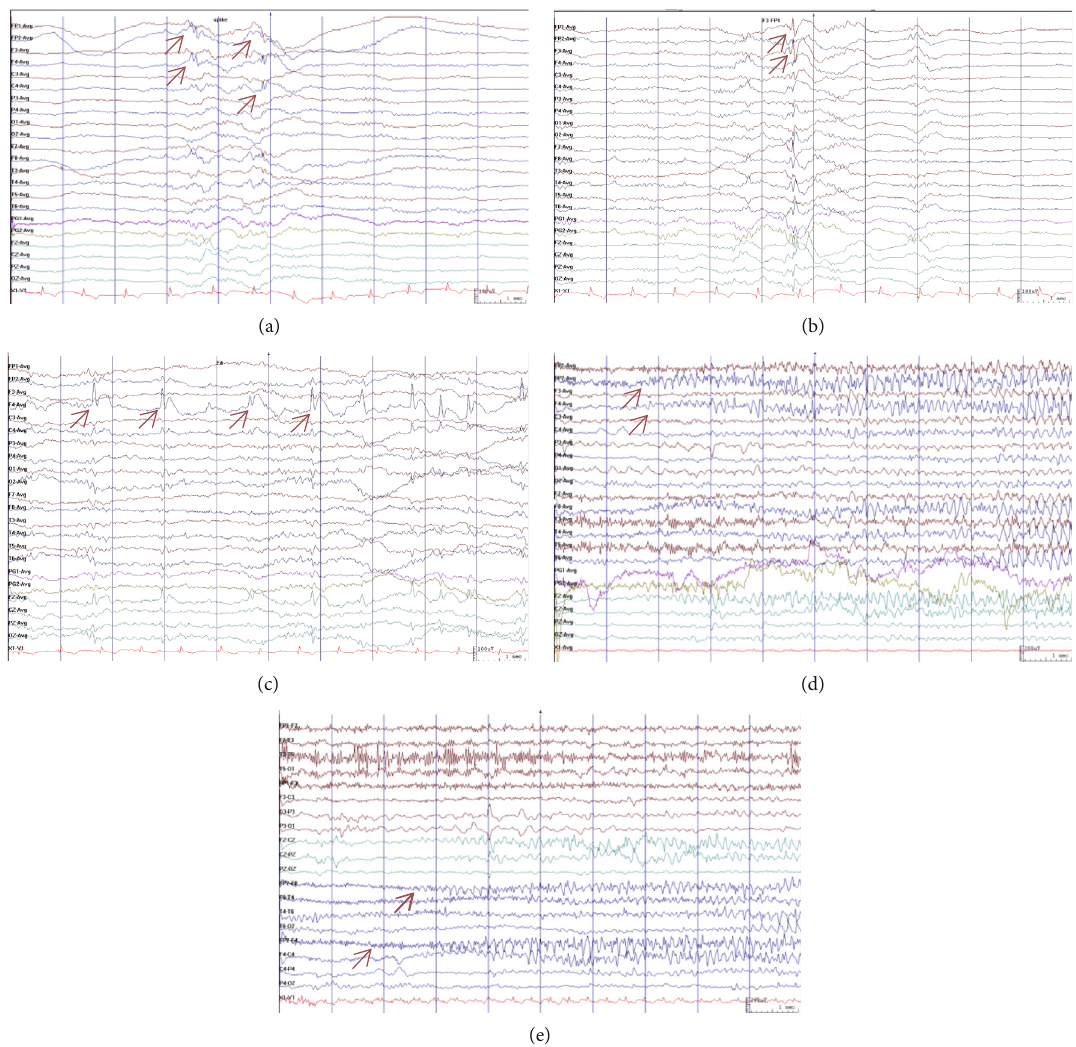
Figure 2: Representative EEG records of all patients. (a, b) Case 3. (c) Case 4. (d, e) Case2. Epileptiform discharges are indicated with arrows in